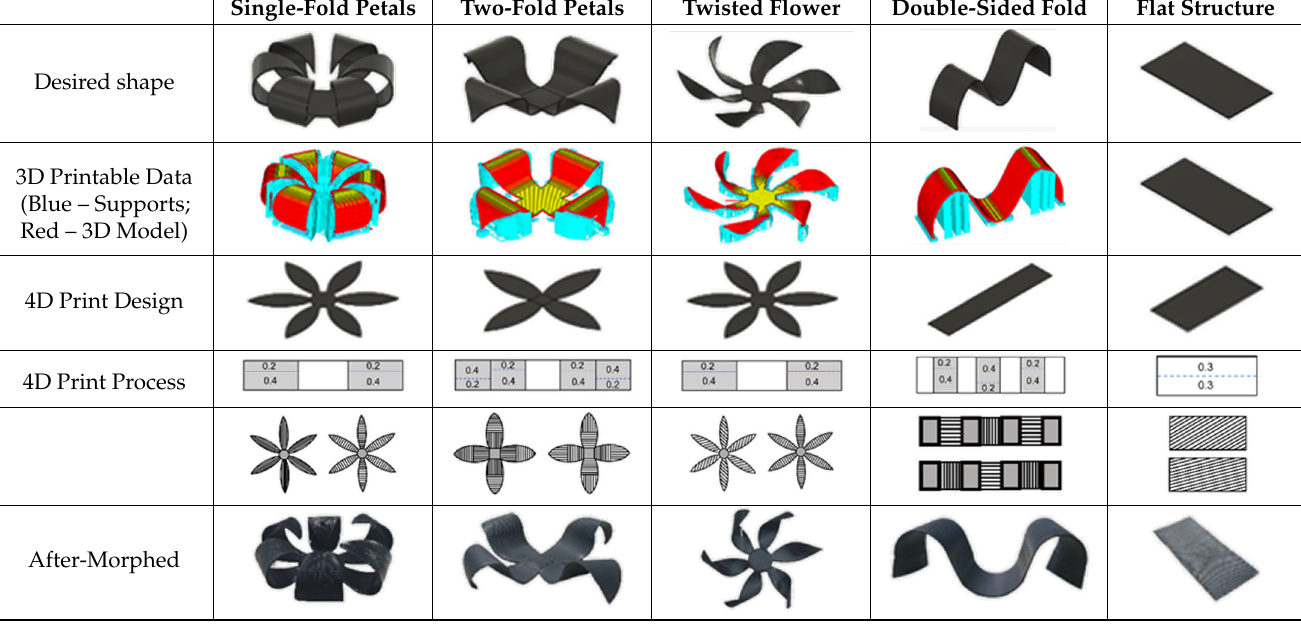
Table 6. Production time, volume, material usage reduction from the presented 4D-printing method.